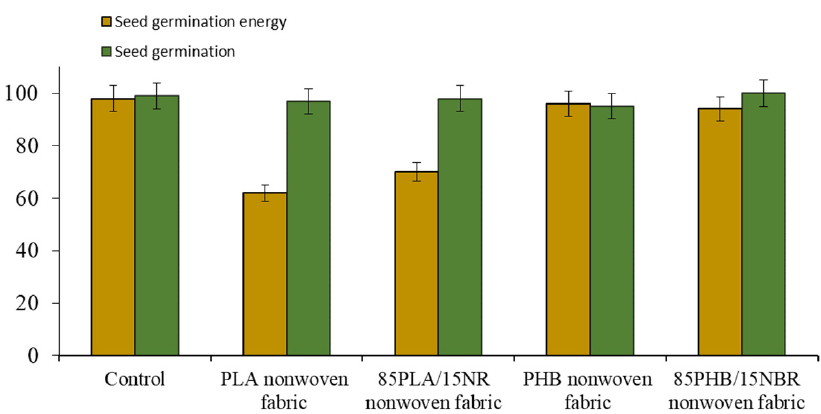
Figure 4. The seed germination energy and the germination of the wheat Yubileinaya 100.